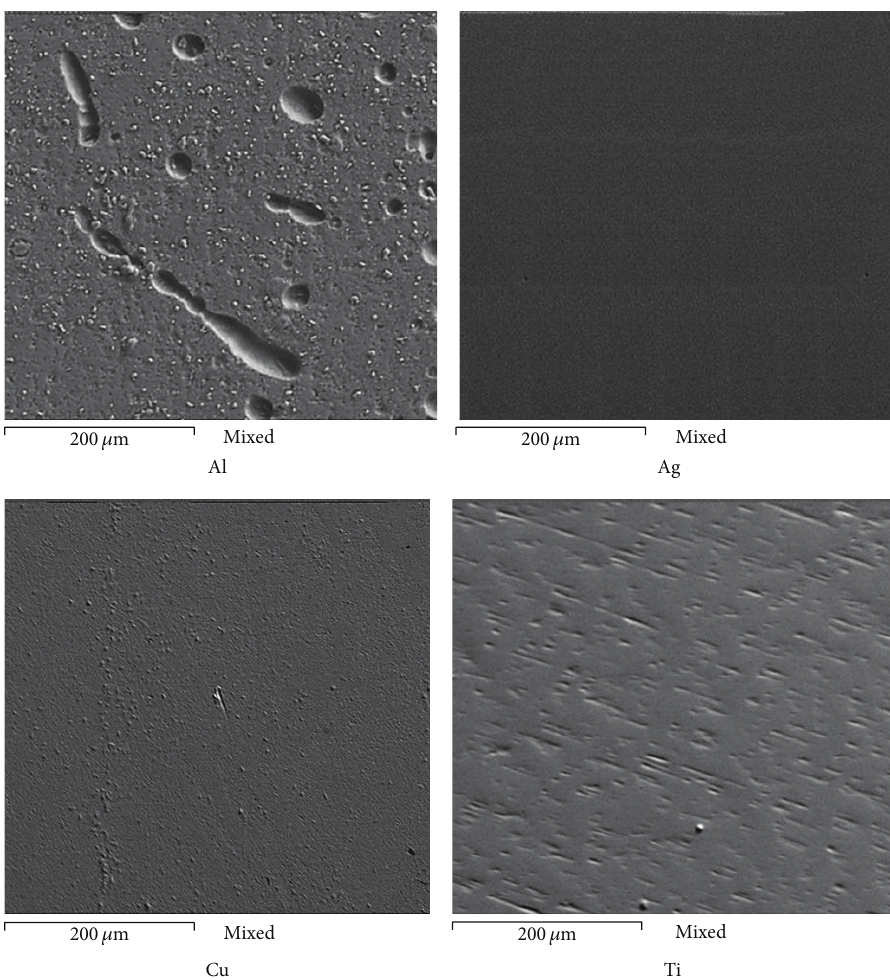
Figure 9: Superficial aspect for Al, Ag, Cu, and Ti, after the corrosion test in artificial saliva at 37 ∘ C for 48